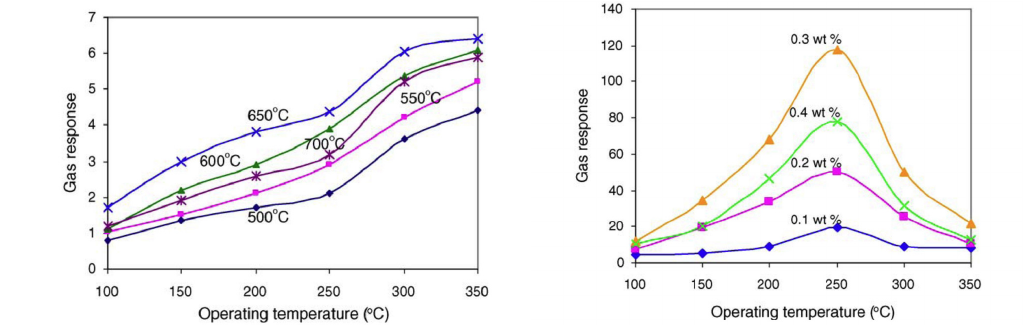
Figure 20. Left, The responses (as %) of pure ZnO thick films fired at varying temperatures to 1,000 ppm of ammonia. Right, showing the optimum operating temperature for ZnO films for sensing 1,000 ppm ammonia with RuO adapted with permission from